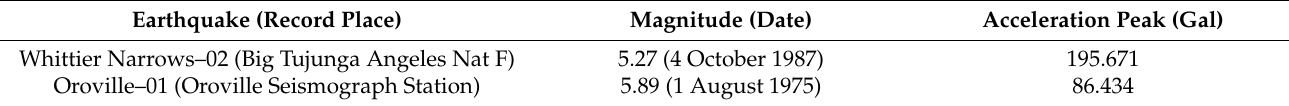
Table 2. Earthquake acceleration records.